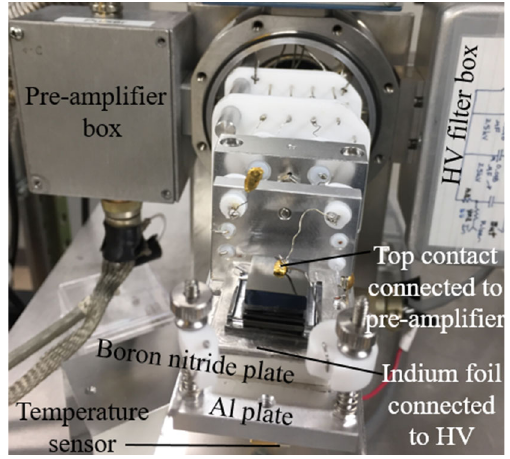
Fig. 2 Internal structure of the vacuum cryostat at USD